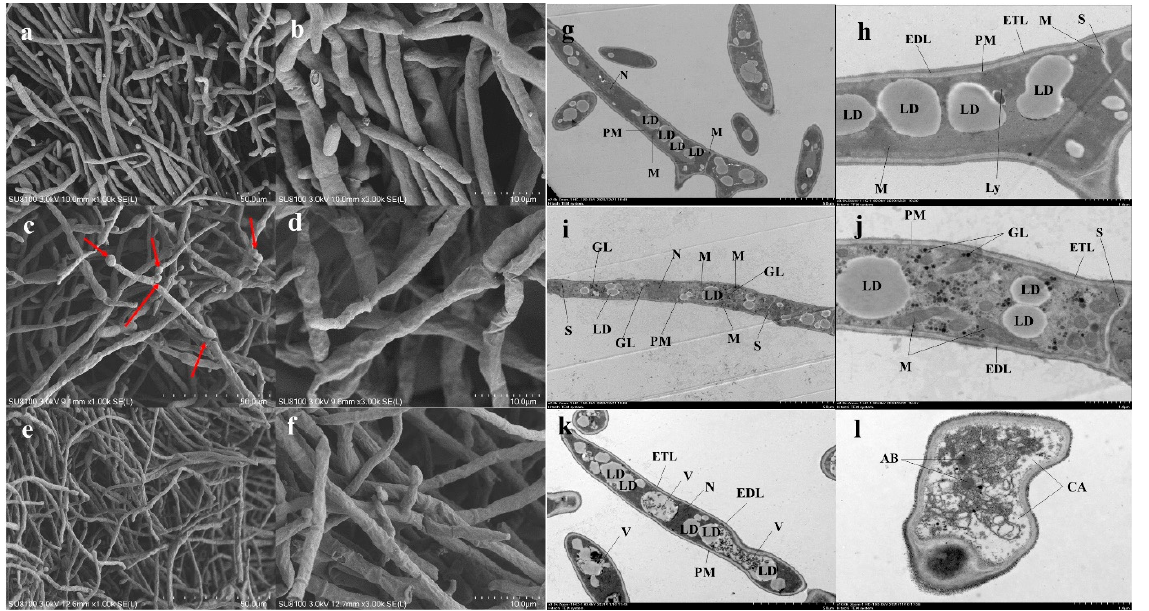
Figure 4. Ultrastructural changes in mycelia being treated with iturin A (60 μ g/mL). ( a , b , g , h ) control group; ( c , d , i , j ) mycelium treated with iturin A for 6 h; ( e , f , k , l ) mycelium treated with iturin A for 24 h. V, vacuole; PM, plasma membrane; S, septum; EDL, external electron-dense outer layer cell wall; ETL, underlying electron-transparent layer; LD, lipid droplets; GL, glycogen; Ly, lysosome; M,